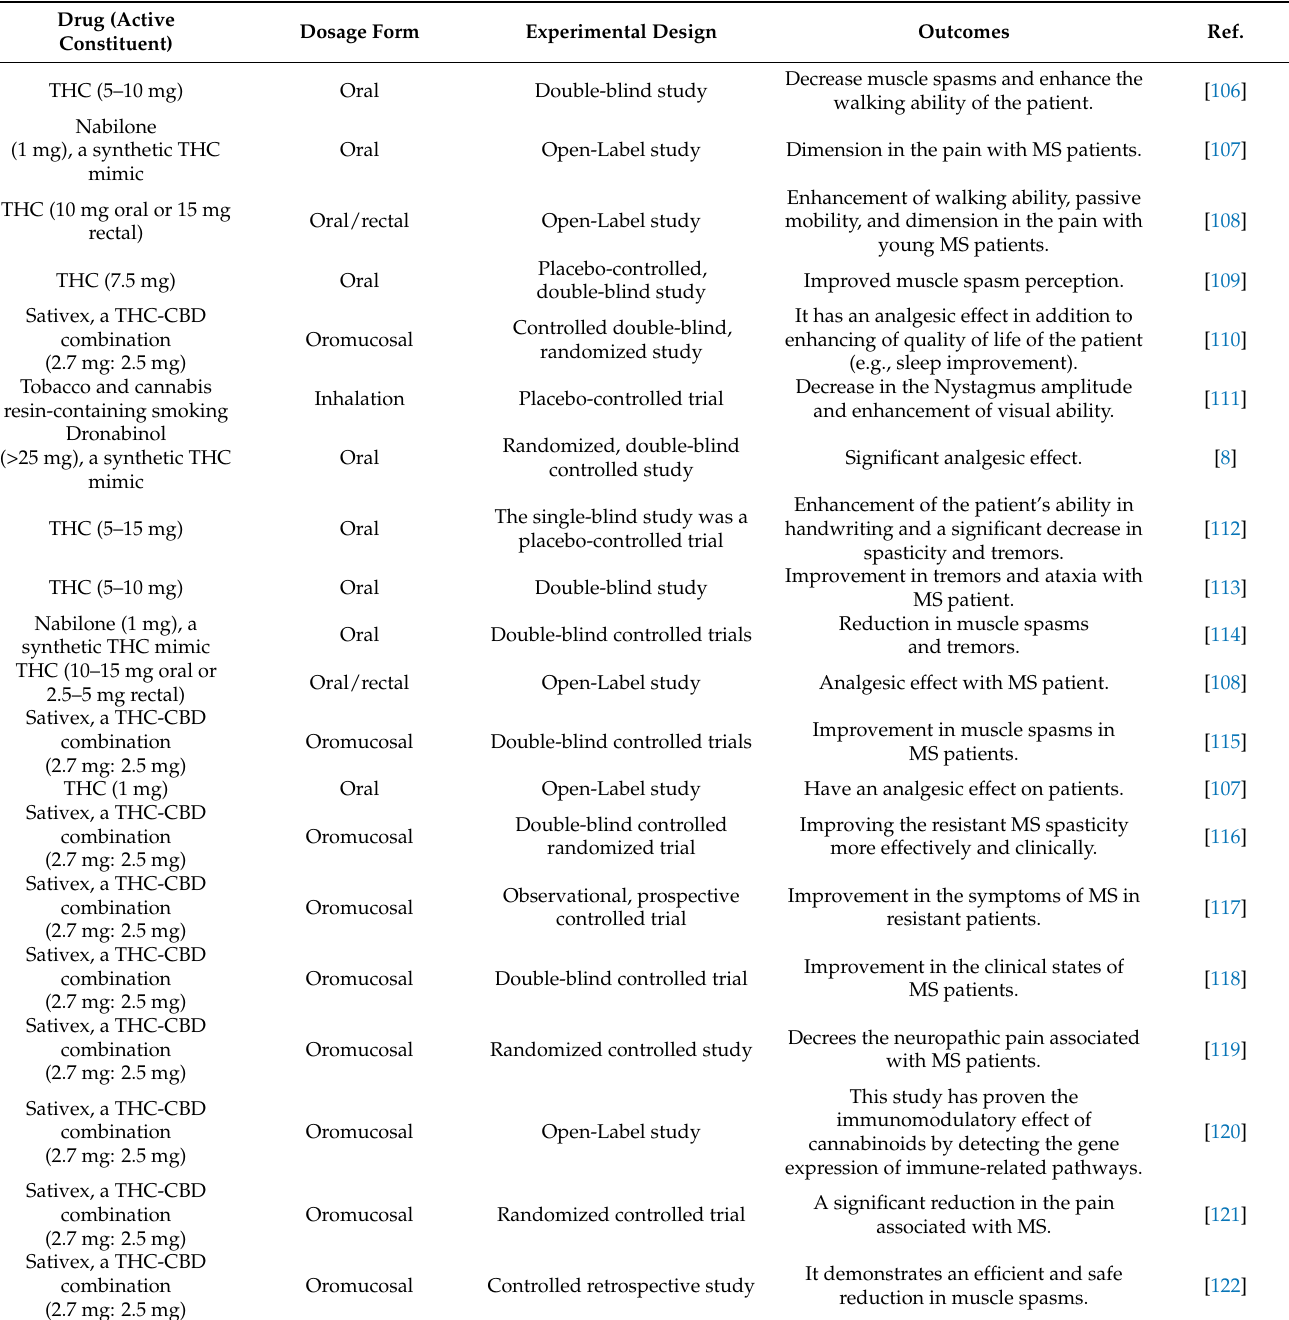
Table 4. Various clinical trials on the use of cannabinoids with MS